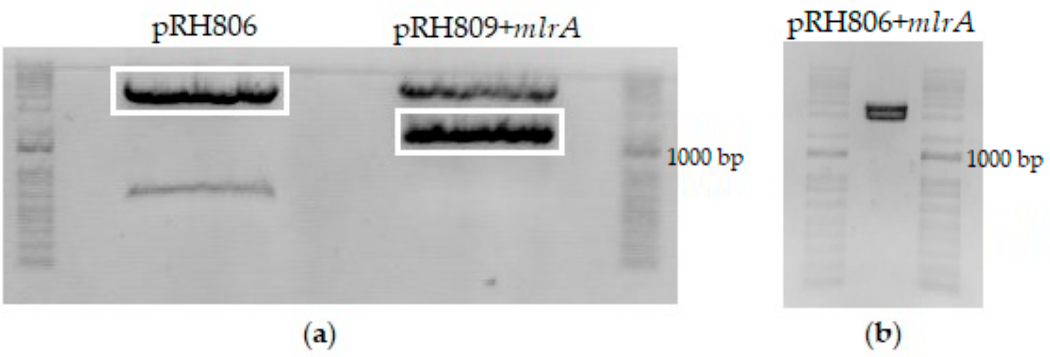
Figure 3. Electrophoresis analyses of procedures applied to construct the integration vector (pRH806+ mlrA ). ( a )—SacI and XhoI digestion products from plasmids pRH809+ mlrA (expression plasmid containing the AgTEF promoter- mlrA -‘ RPL41B terminator) and pRH806 (vector to chromosomal integration). Bands marked containing 4610 bp and 1906 bp were excised, purified, and ligated to construct the new pRH806+ mlrA plasmid. ( b )—pRH806+ mlrA vector digested with BssHII enzyme. Two DNA fragments were produced. The shortest fragment (2925 bp) contains URA3 homology regions and the integrating expression cassette.